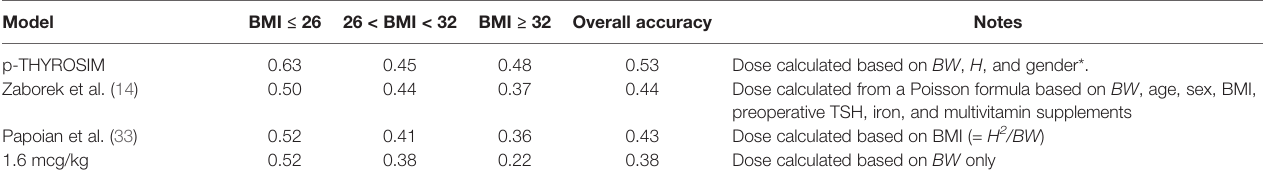
TABLE 2 | LT4 dose predictions classi fi ed into BMI categories for p-THYROSIM and 3 other LT4 dosing schemes. Model